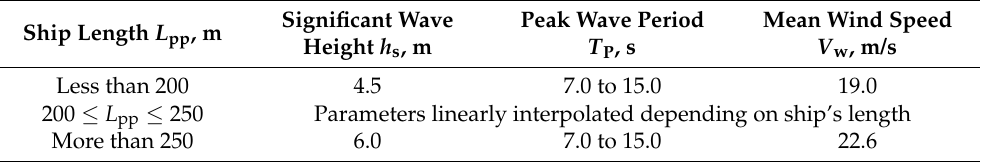
Table 1. Definition of the ship-size-dependent adverse